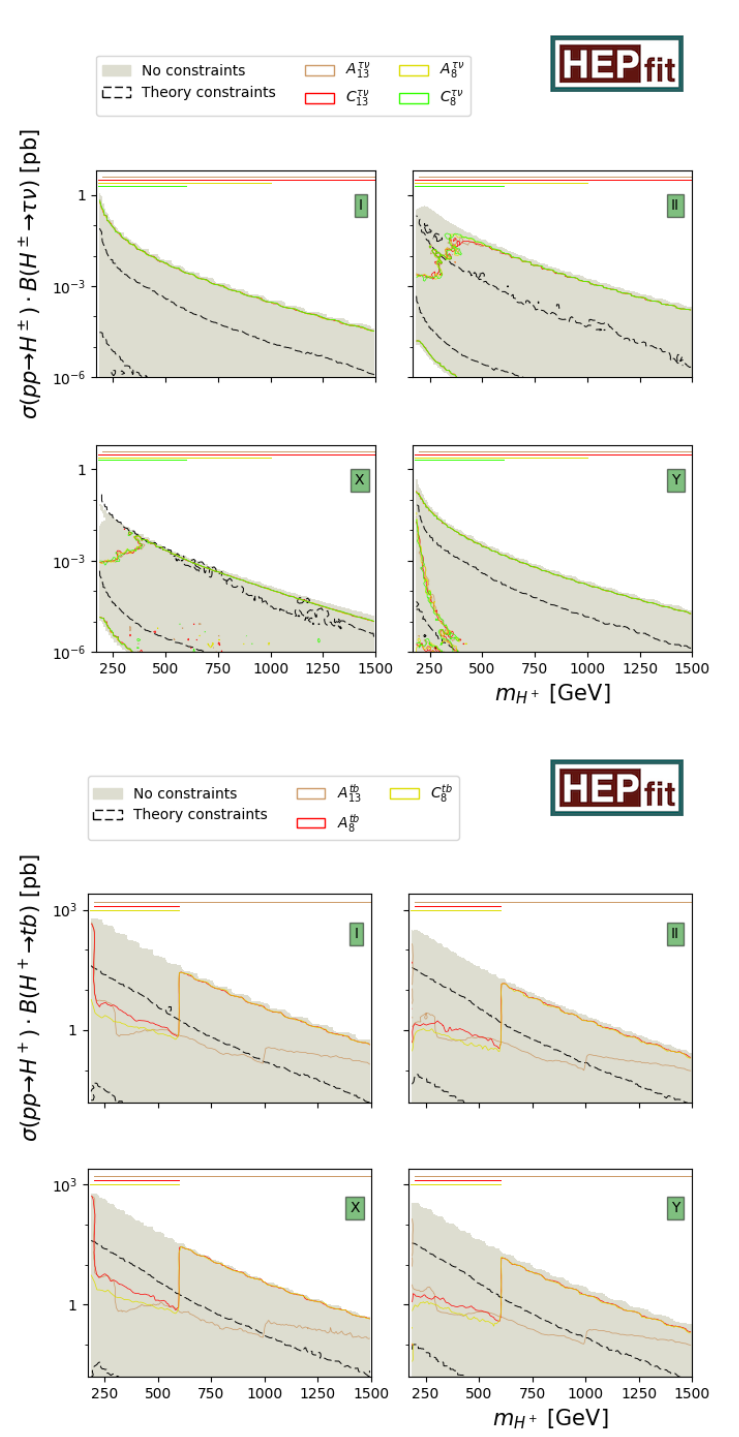
Figure 12 . 95% contours of the single searches for H + ! (cid:28)(cid:23) (top) and H + ! tb (bottom) in the (cid:27) (cid:1) B vs. m planes for the four 2HDM types. For details, see text. H +